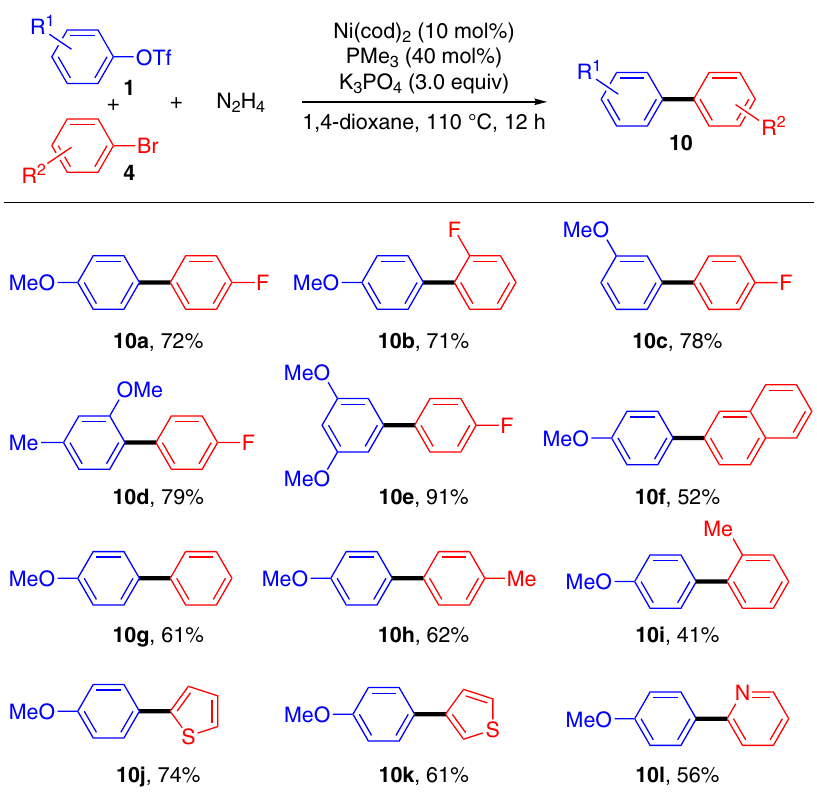
Fig. 6 Cross-coupling between aryl tri fl ates 1 and bromides 4 . Reaction conditions: 1 (0.1 mmol), 4 (0.3 mmol), N 2 H 4 (0.2 mmol), Ni(cod) 2 (10 mol%), PMe 3 (40 mol%), K 3 PO 4 (0.6 mmol), 1,4-dioxane (1.0 mL), 110 °C, 12 h under N 2 . Reported yields are the isolated